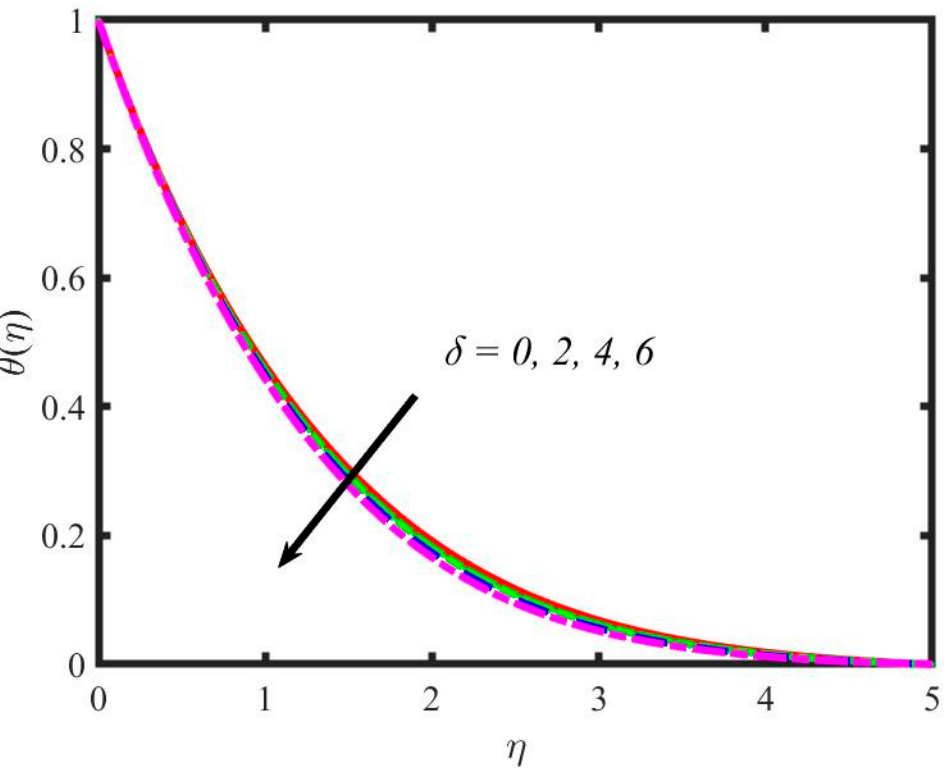
Figure 8. Variations in nanoparticle temperature for microorganisms’ parameter.